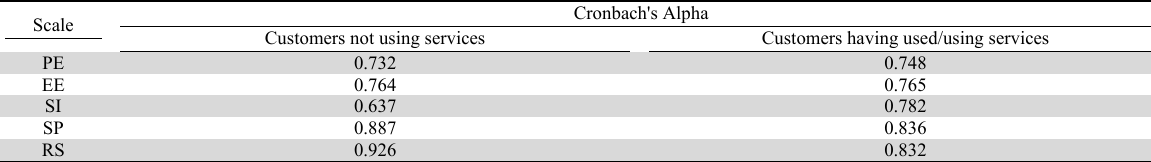
Test results of scale